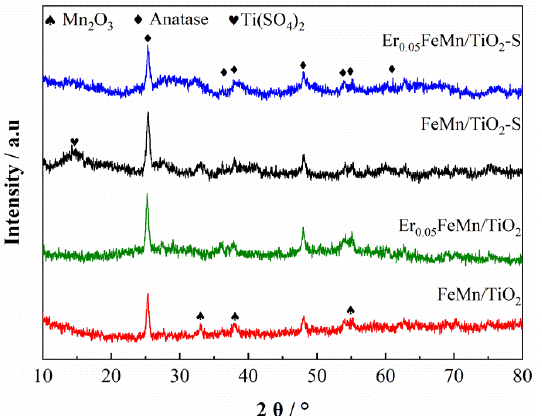
Figure 3. XRD patterns of the fresh and used FeMn/TiO 2 and Er 0.05 FeMn/TiO 2 catalysts.